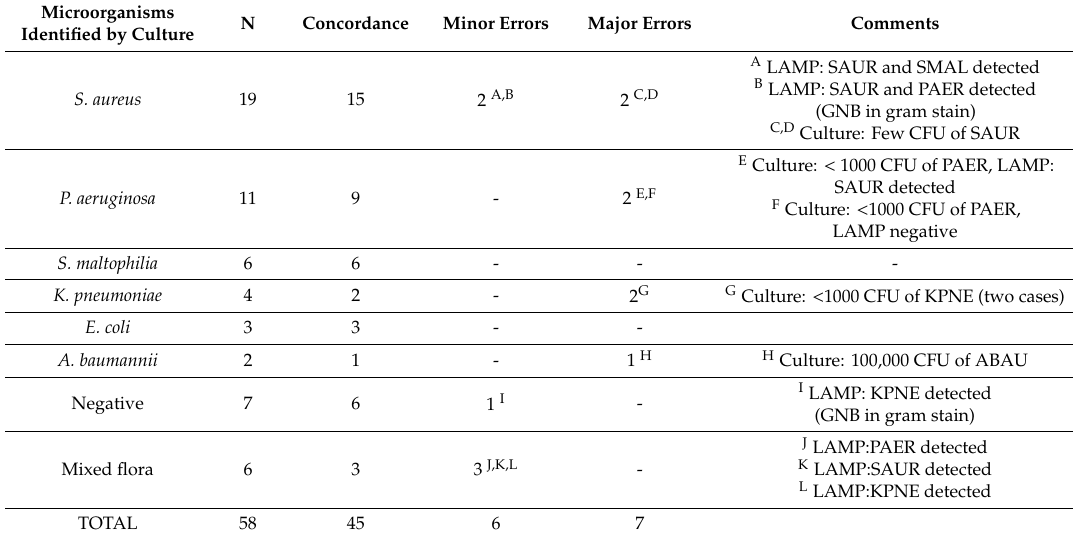
Table 1. Loop-mediated isothermal amplification (LAMP) results from BAL samples according to the result obtained by culture.